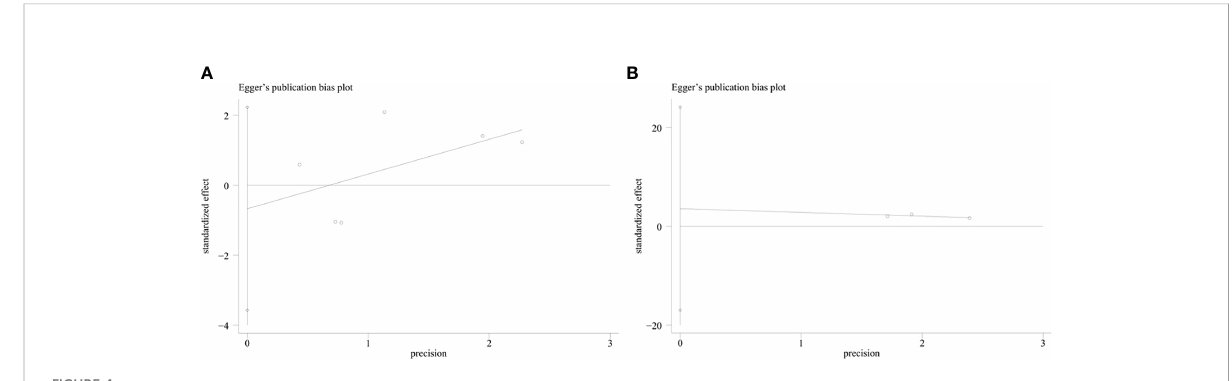
FIGURE 4 Result of Egger ’ s test. (A) Progression-free survival. (B) Disease-free